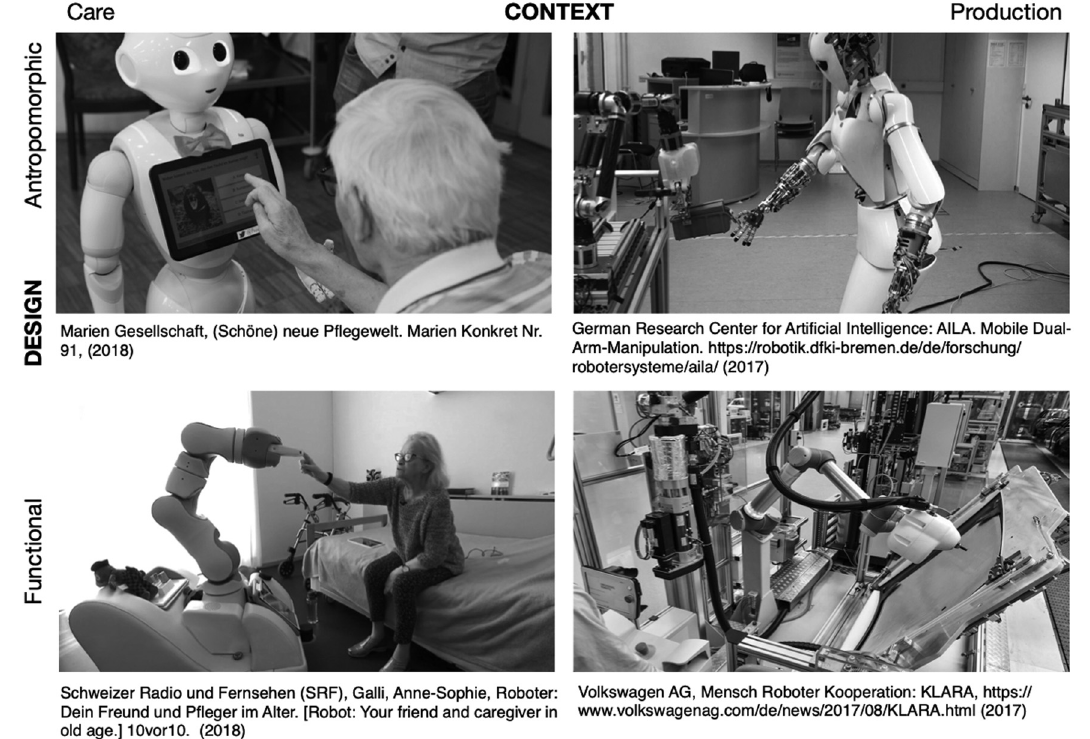
Figure 1: Images for illustrating the scenarios with two di ff erent designs and in two di ff erent